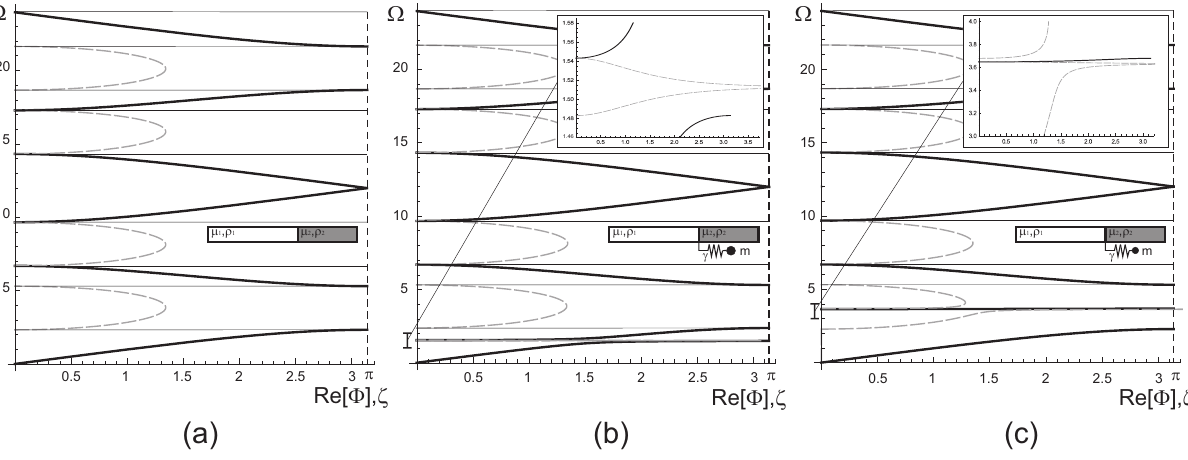
Figure 6. Oscillator in parallel. Dispersion curves (continuous black lines) and decay exponent (dashed grey lines). Normalised frequency Ω is given for ξ c = 0.22 and η c = 0.5. ( a ) Bi-layered laminate. ( b ) Bi-layered laminate with oscillator, with ξ m = 8.71, η m = 1.260. ( c ) Bi-layered laminate with oscillator, with ξ m = 8.71, η m =